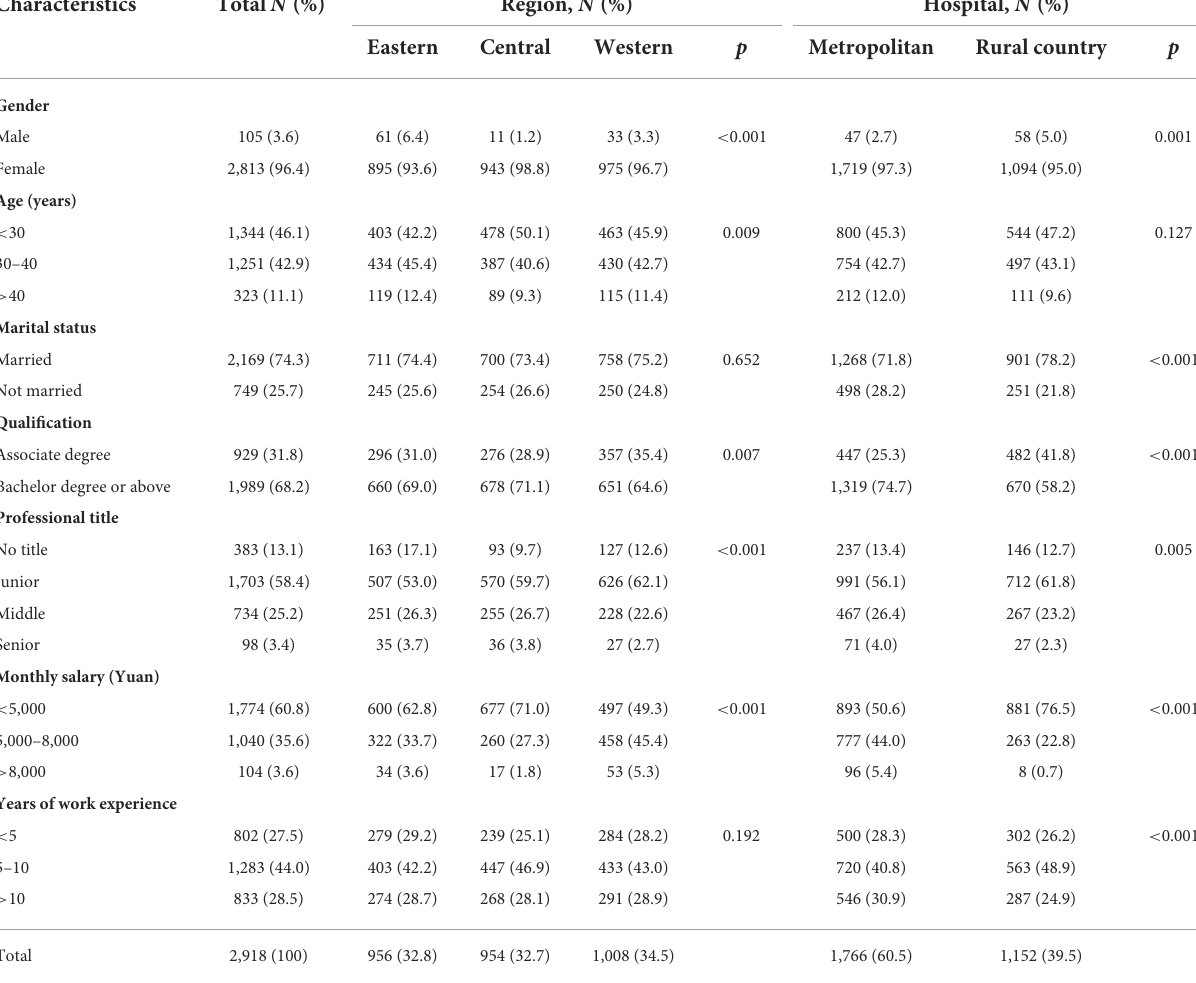
TABLE 2 Characteristics of study participants ( n =